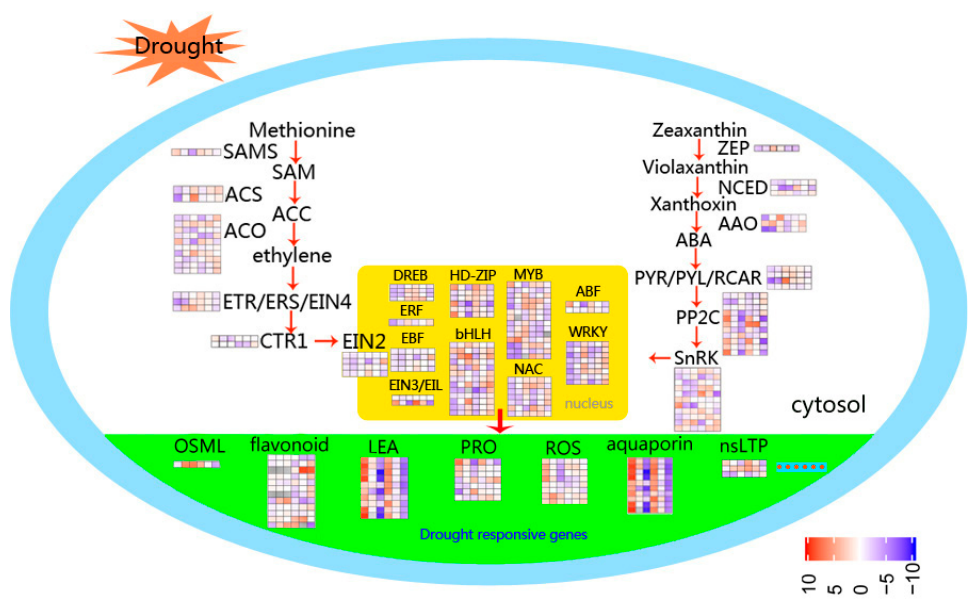
Figure 8. Schematic representation of the main processes involved in drought response in foxtail millet. The color scale represents increased (red) or decreased (blue) fold-change expression of DEGs in samples exposed to drought stress and re-watering.